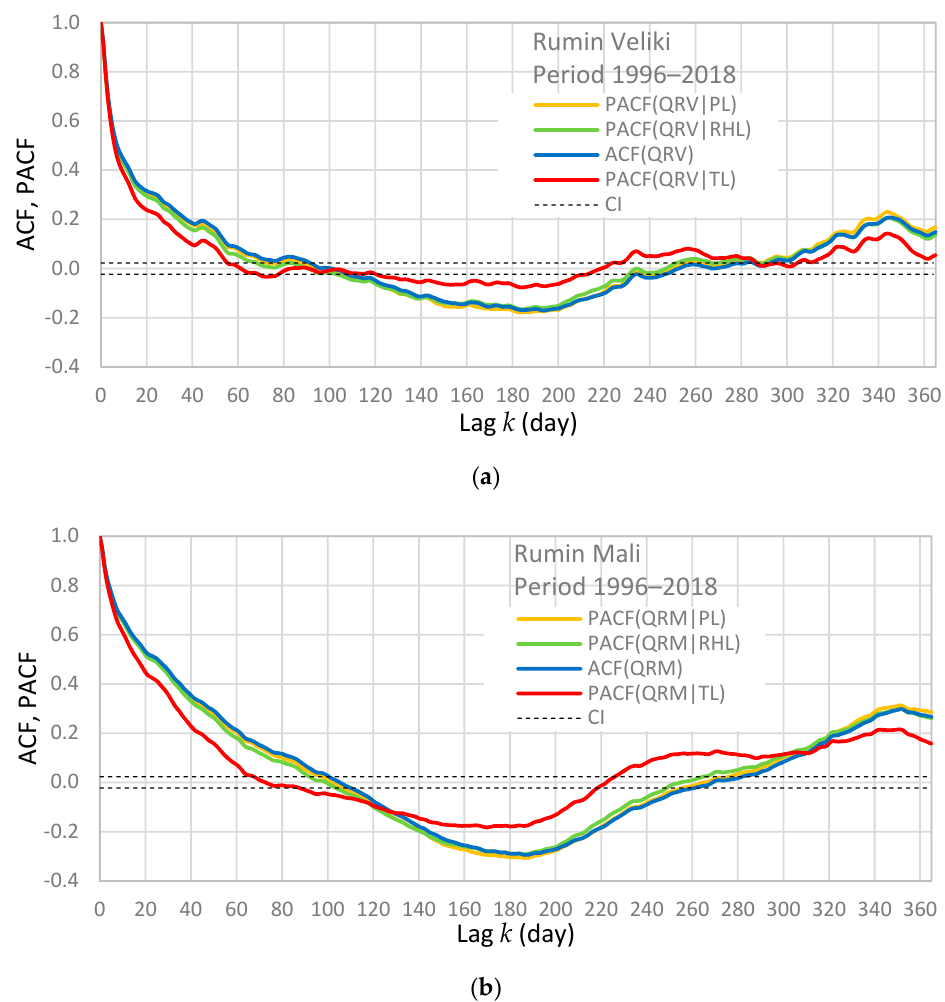
Figure 8. Partial autocorrelation function (PACF) of discharge for the spring: ( a ) Rumin Veliki (Q RV ), and ( b ) Rumin Mali (Q RM ), where the control series is rainfall (P L ), air temperature (T L ) and relative humidity (RH L ) from MS Livno, for period 1996–2018. CI—confidence interval.